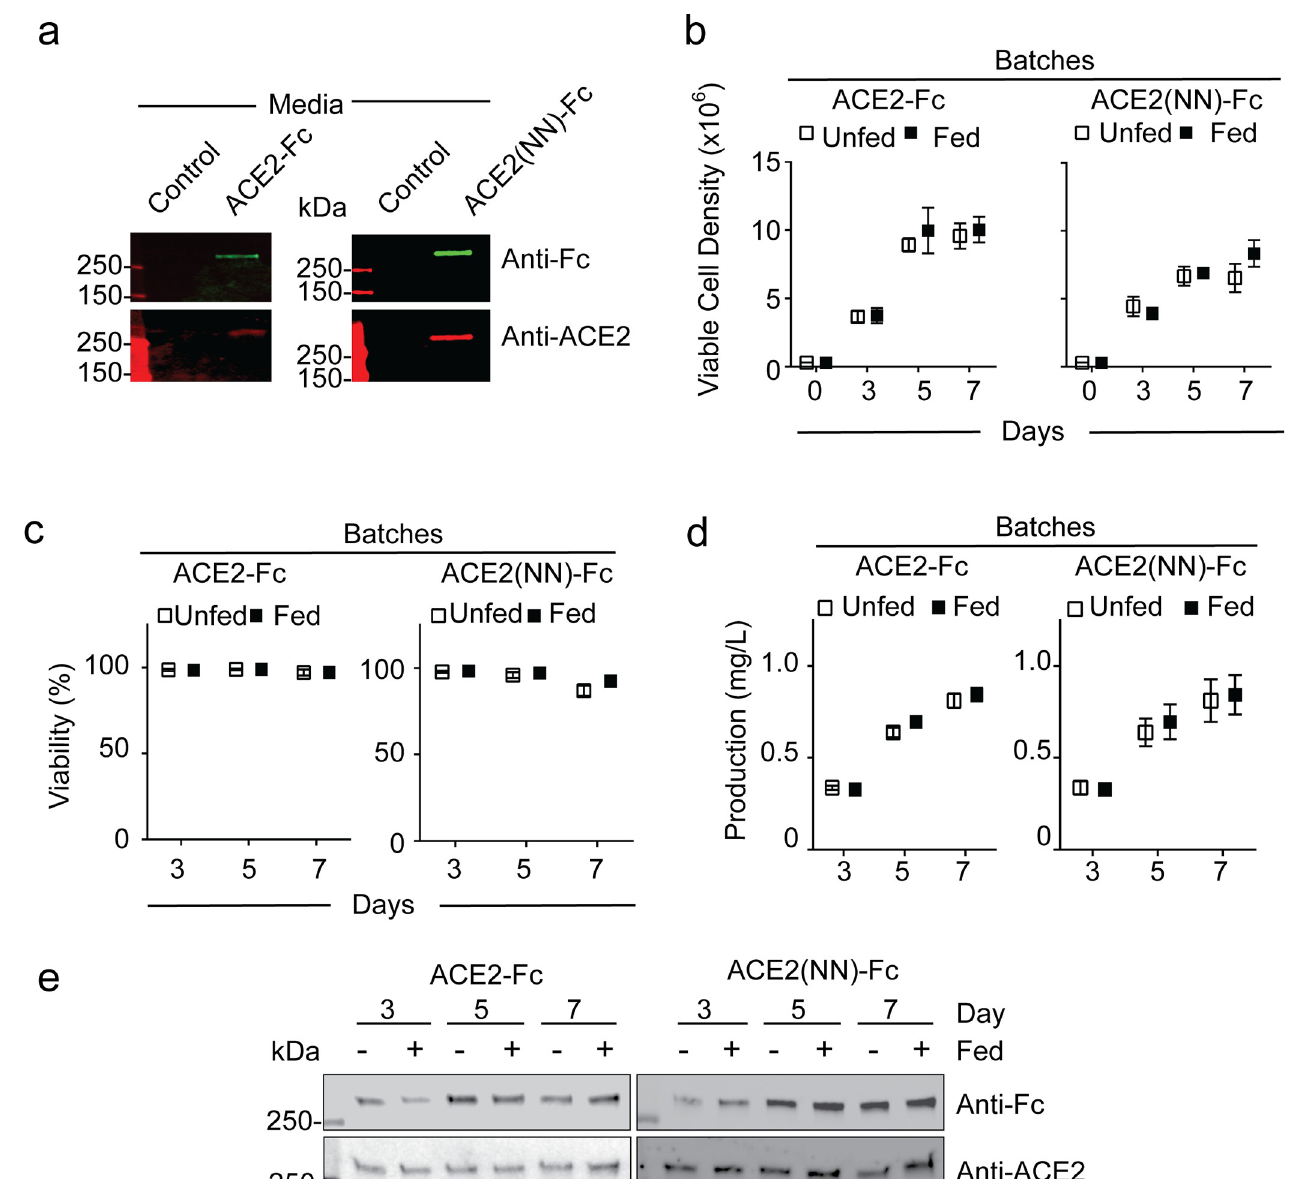
Fig 1. Upstream production of ACE2-Fc and ACE2(NN)-Fc using stable CHO cell lines. ( a ) Representative IgG-Fc and ACE2 immunoblots using harvest media (15 μ L) compared to blank media. CHO cell viable density ( b ) and viability ( c ) over a 7-day campaign using fed and unfed cultivation (n = 3). ( d ) Protein titer of the ACE2-Fc and ACE2(NN)-Fc during the campaigns under fed and unfed conditions (n = 3). ( e ) Representative IgG-Fc and ACE2 immunoblots using cell free harvest media (15 μ L) collected on day 3, 5, and 7. Dots represent mean ± standard deviation.